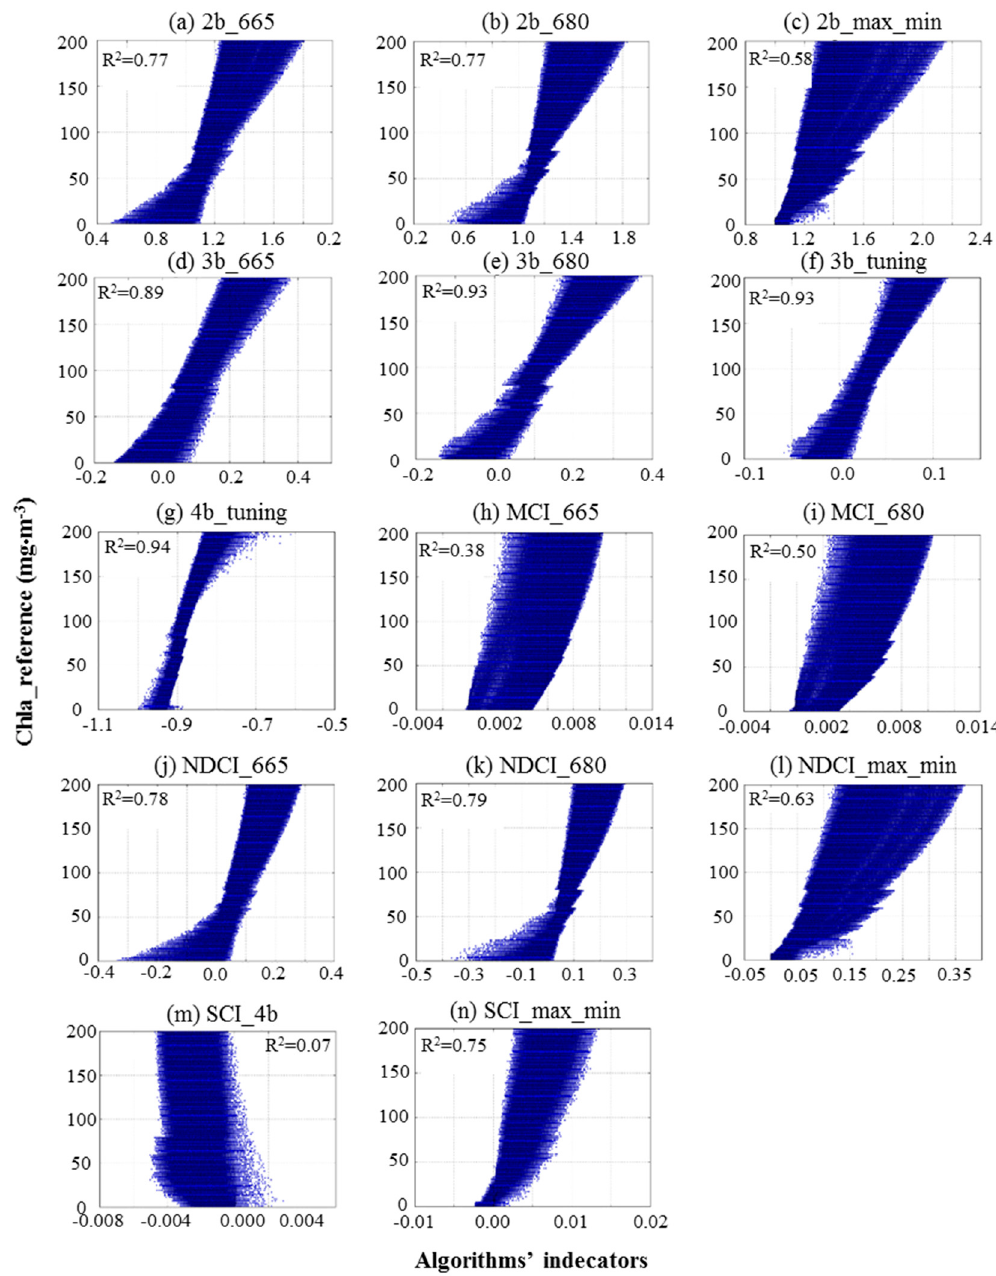
Figure 5. Reference reflectance versus algorithms’ ratio for the calibration dataset of simulated reflectance.